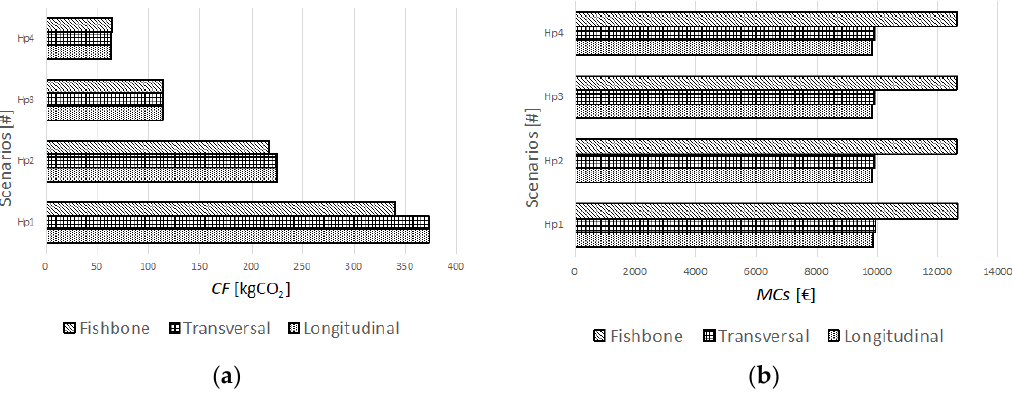
Figure 6. Log report generate by the model regarding the Carbon Footprint ( a ) and Management Costs ( b ) evaluation in all scenarios.